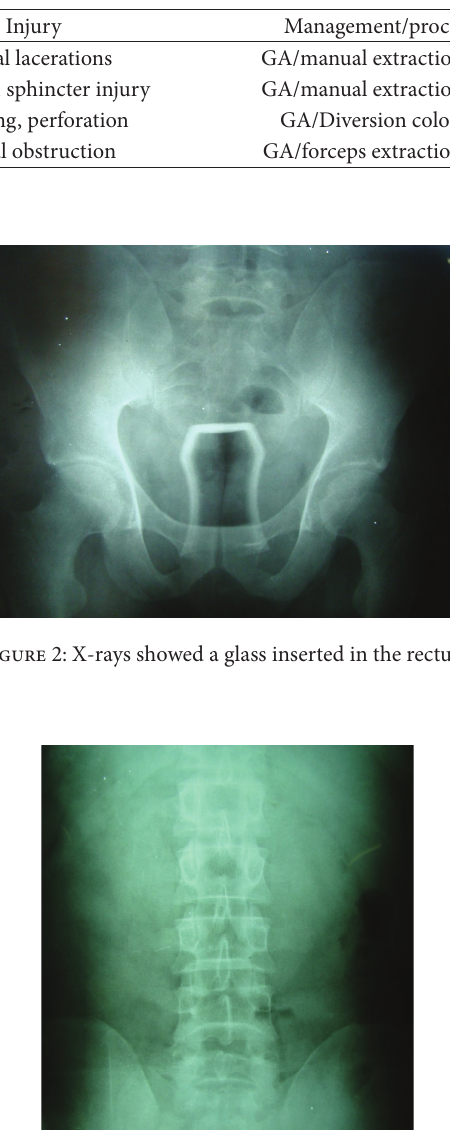
Table 1: Characteristics of patients with anorectal injuries related to autoerotic activity.